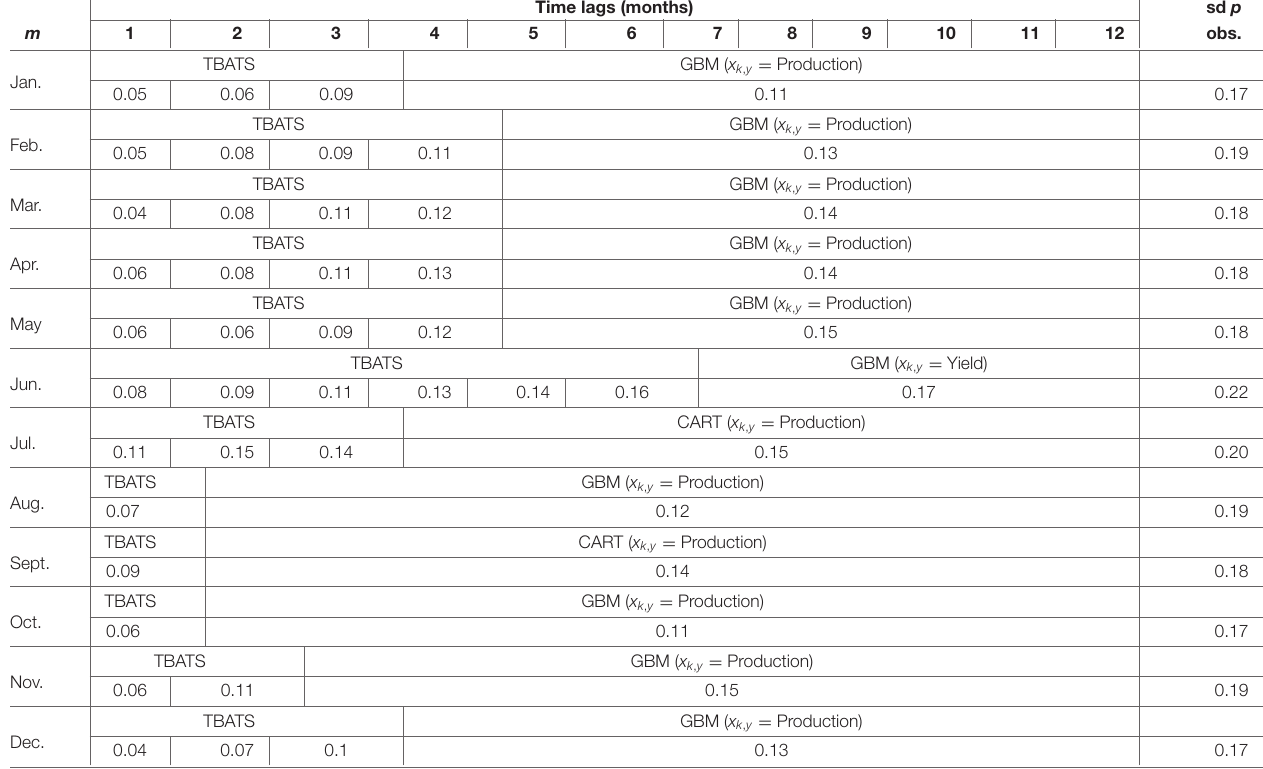
TABLE 1 | Best forecasting options for different